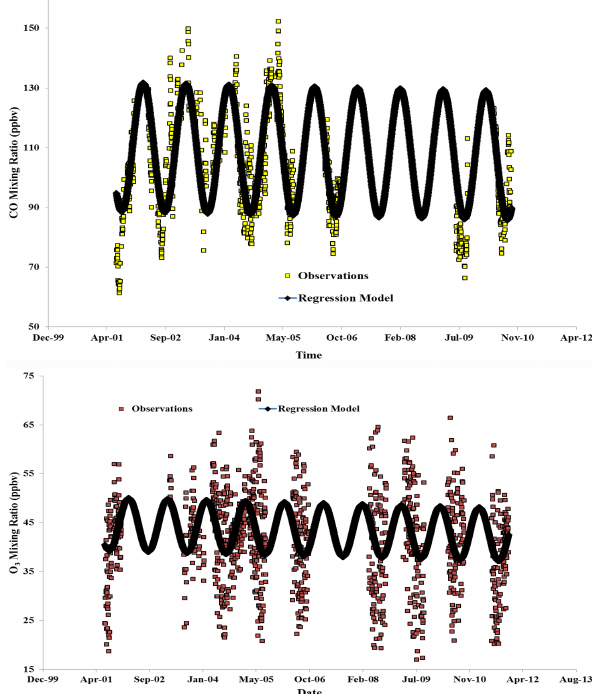
Fig. 3. Seasonal variation of CO (top) and O 3 (bottom) at PMO (September 2004–August 2005) as indicated by GEOS-Chem model simulations (yellow), in situ measurements (dark brown) and satellite observations (AIRS for CO and TES for O 3 ) (light blue). The thick (thin) bars represent the 67% (90%) confidence inter- vals. The mean and median are represented with red and green dots, respectively.The statistics are based on daily (24h) averages.